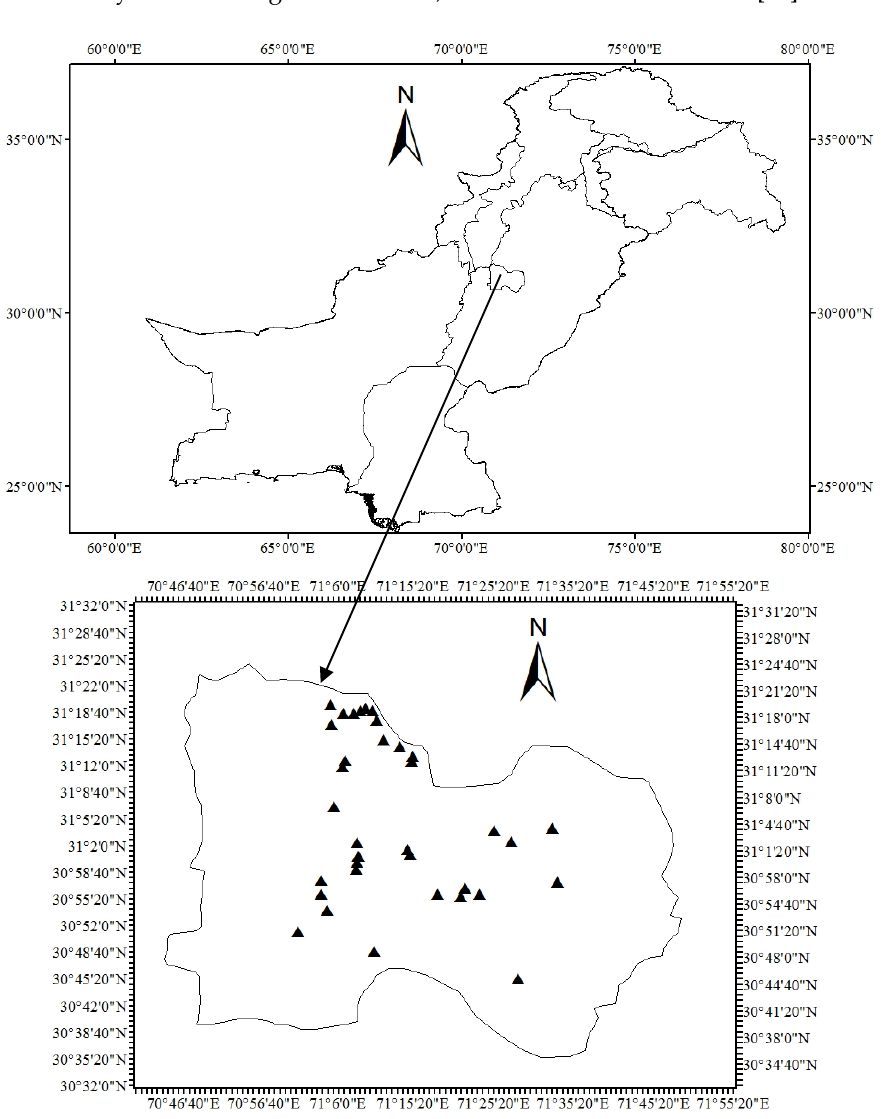
Figure 1. Geographical location of citrus plant tissues (leaves) and associated soil sampling Sites in Layyah district.